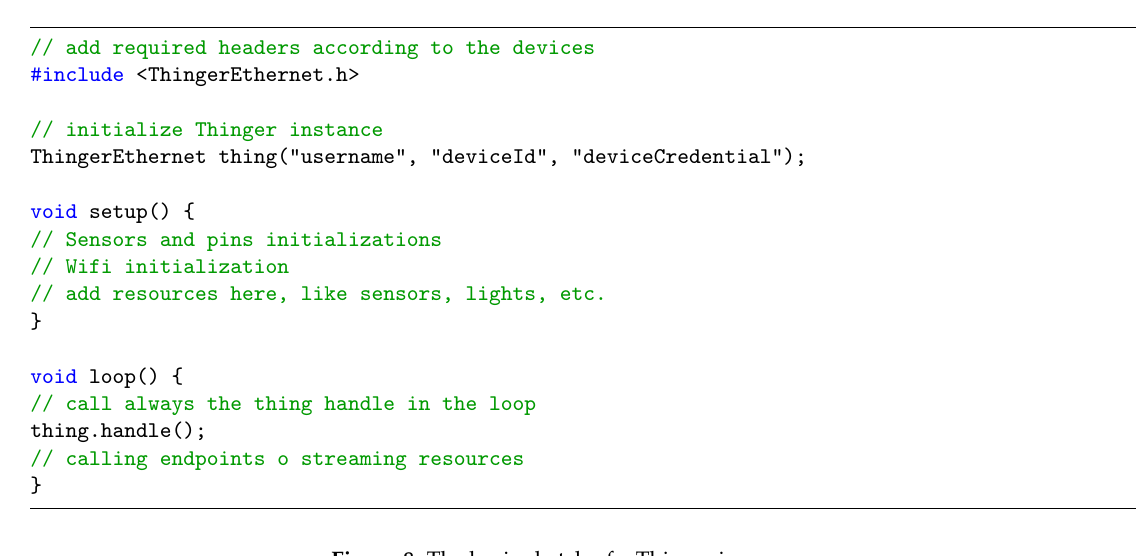
Figure 8. The basic sketch of a Thinger.io